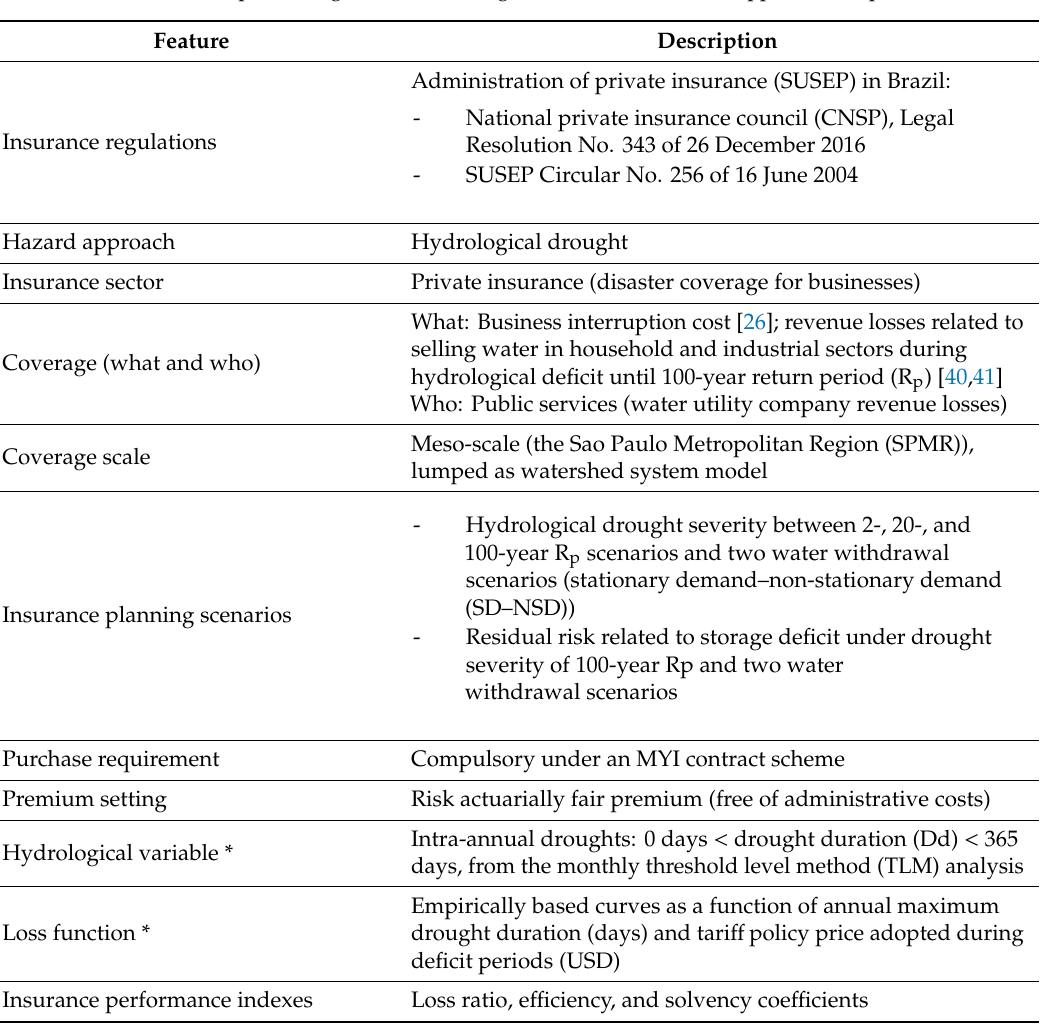
Table 2. Features of adopted drought insurance design under the MTRH-SHS approach (adapted from